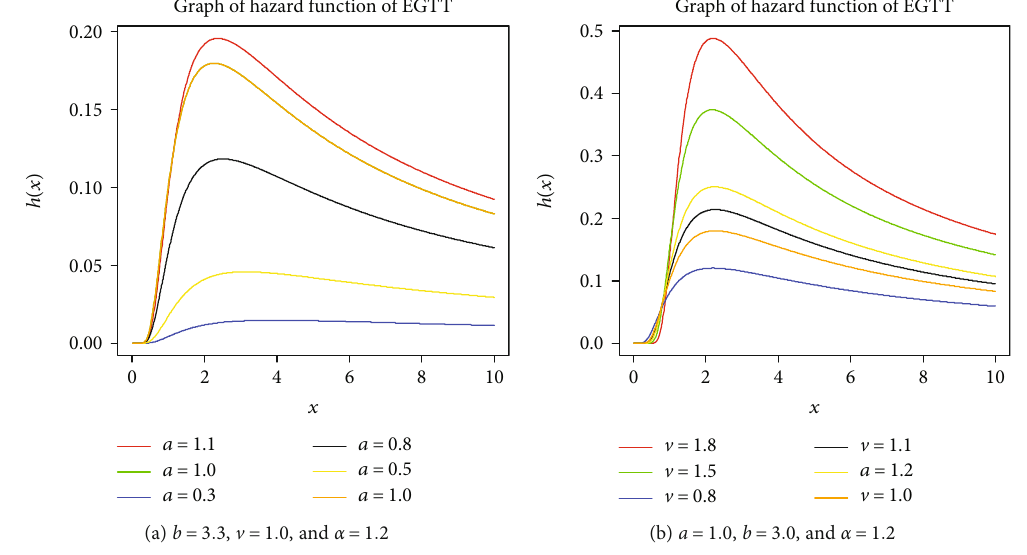
Figure 4: The graphs of the hazard function of EGTT